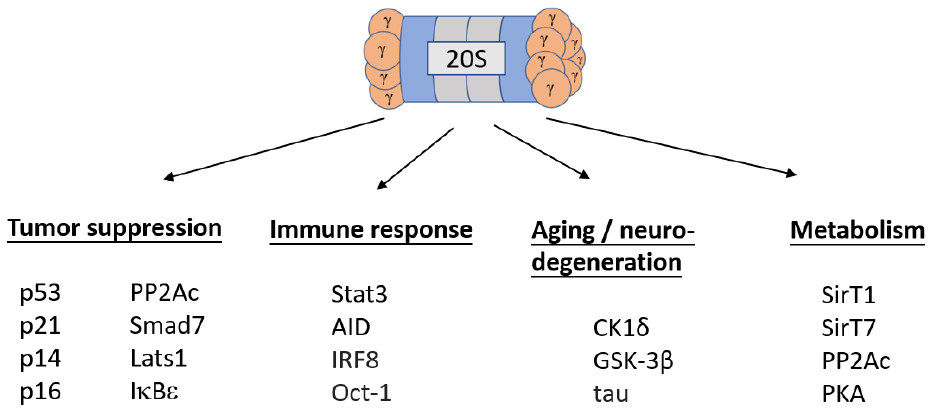
Figure 1. Downstream targets of the REG γ -proteasome. From tumor suppressors and immune response factors to proteins involved in aging and metabolism, REG γ regulates a broad array of bio- logical functions via the degradation of key proteins and peptides. For abbreviations, extended names are as follows: Protein Phosphatase 2 A catalytic subunit (PP2Ac), Mothers against decapentaplegic 7 (Smad7), Large Tumor Suppressor Kinase 1 (Lats1), Inhibitor of κ B epsilon (I κ B ε ), Signal Transducer and Activator of Transcription 3 (Stat3), Activation-Induced Deaminase (AID), Interferon Regulatory Factor 8 (IRF8), Casein Kinase 1 sigma (CK1 δ ), Glycogen Synthase Kinase-3 beta (GSK-3 β ), Sirtuin 1 (SirT1), Sirtuin 7 (SirT7), and Protein Kinase A (PKA).